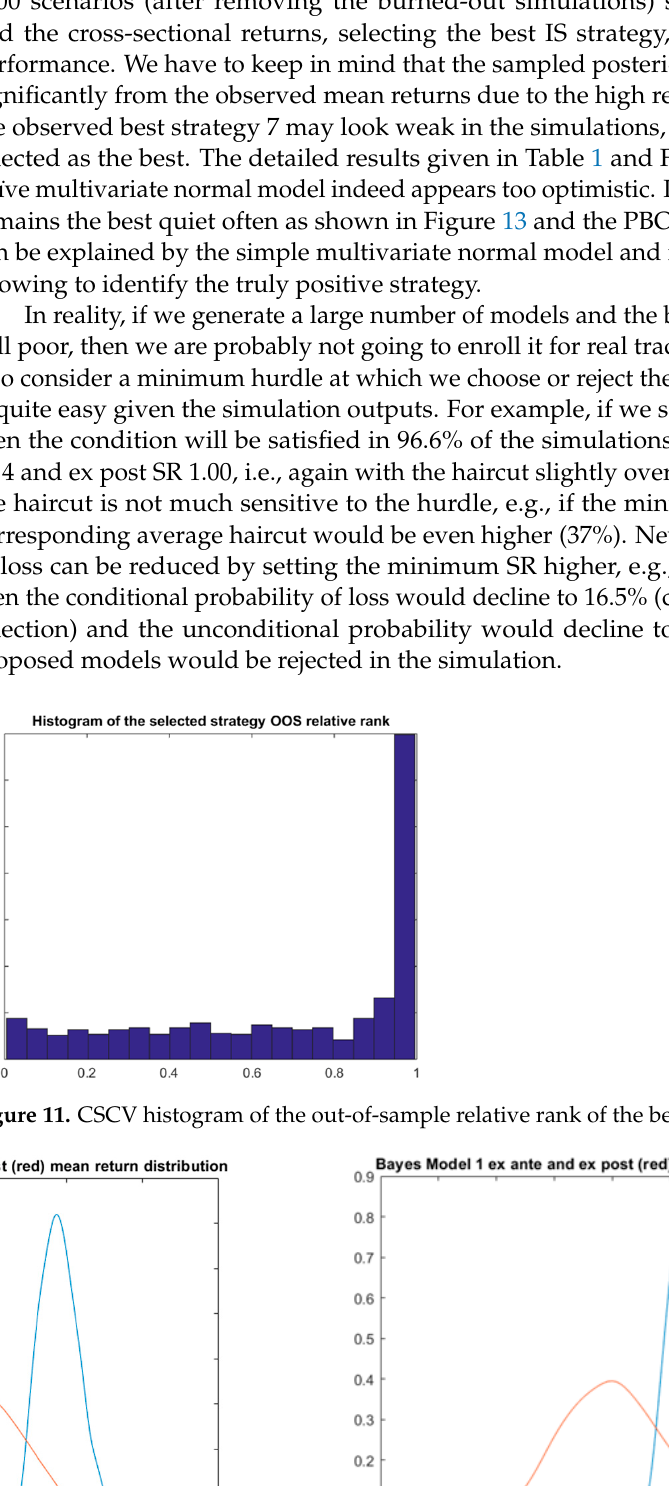
Figure 12. Bayes model 1 simulation of the ex ante and ex post probability densities.